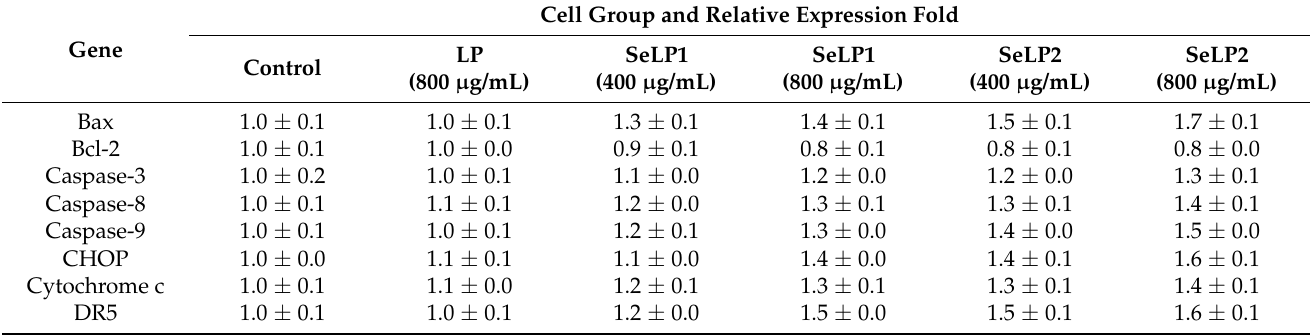
Table 3. Expression changes of the eight apoptosis-related genes in HT-29 cells exposed to longan polysaccharides (LP) and two selenylated polysaccharides (SeLP1 and SeLP2). Cell Group and Relative Expression